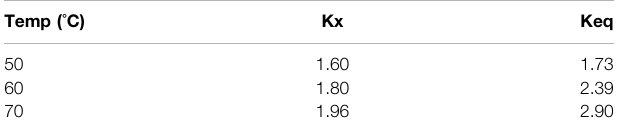
TABLE 2 | Equilibrium constants of glycolic acid esteri fi cation with